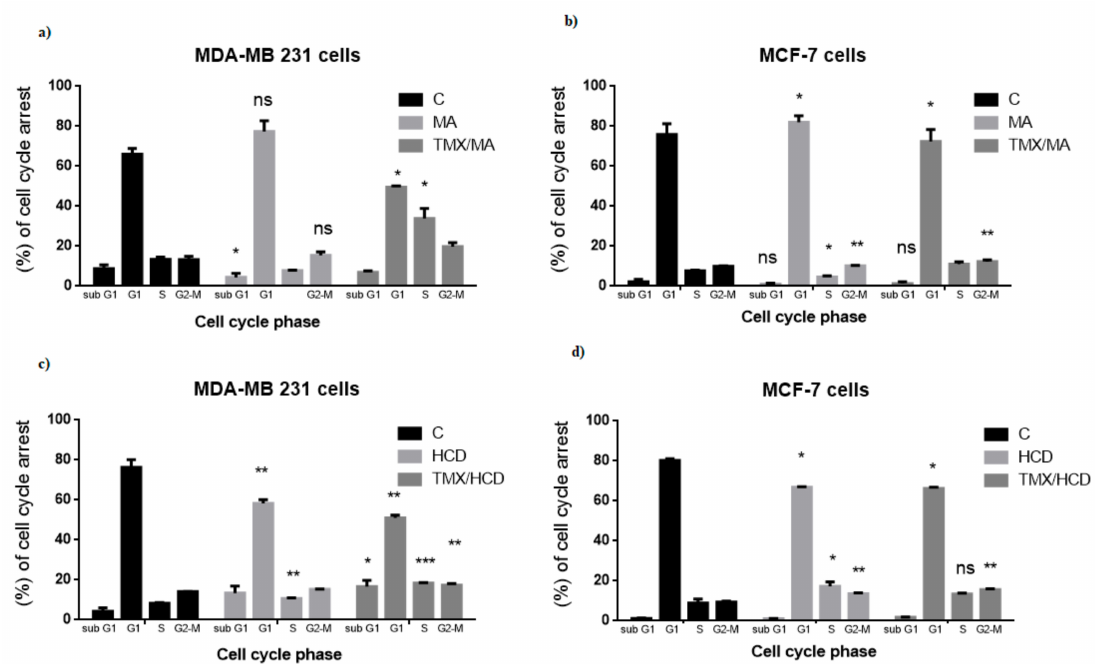
Figure 3. Effect of MA or HCD on TMX treated cell cycle progression ( a ) MDA-MB 231 breast